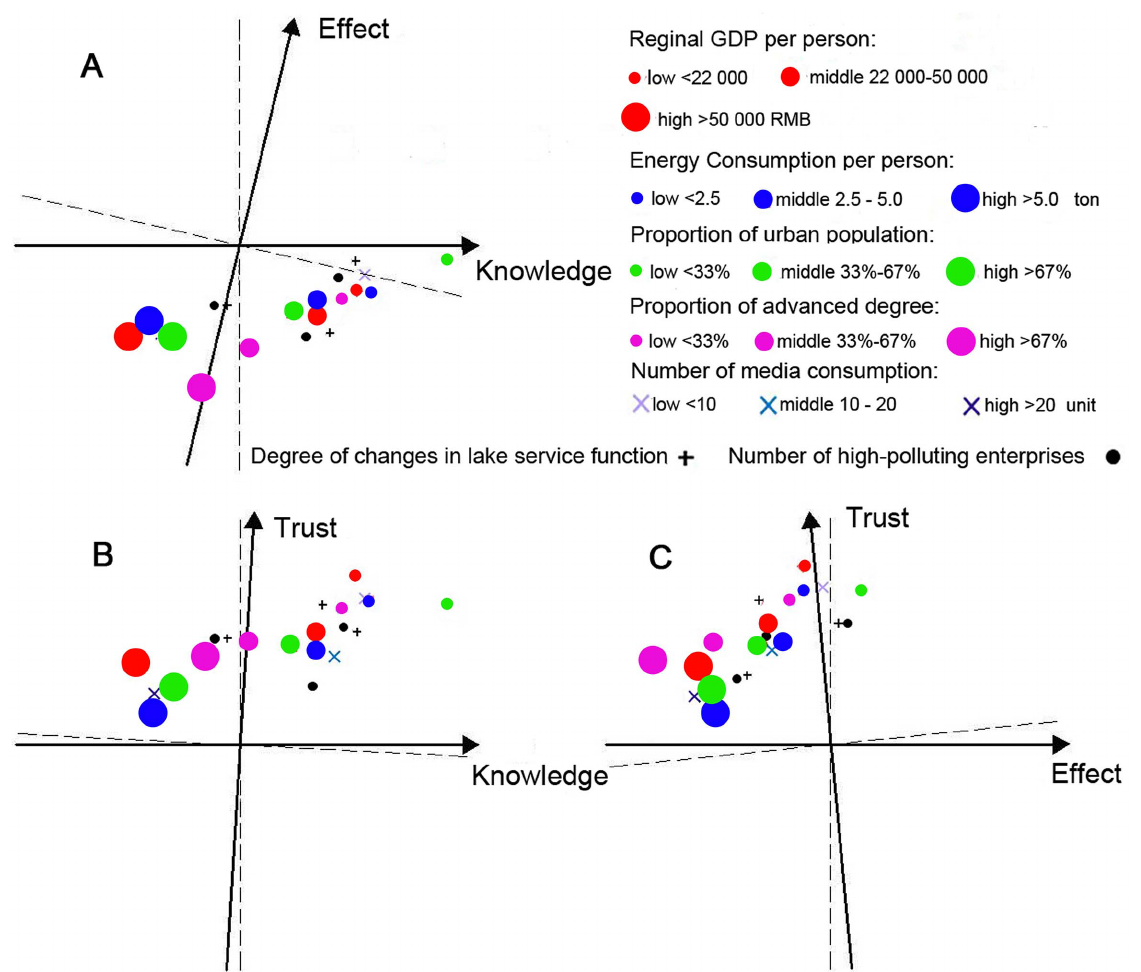
Figure 5. Public risk tolerance for different social conditions plotted in the factor space. different socio-economic status or socio-educational level may